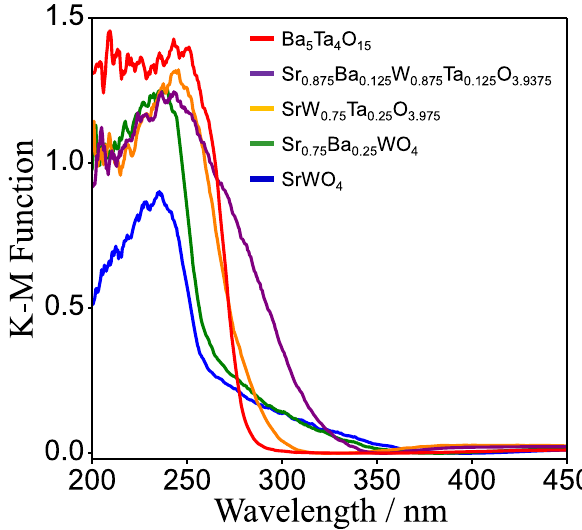
Fig. 2 UV–Vis diffuse reflectance spectra of Sr 1 - x Ba x W 1 - y Ta y - O 4 - (1/2) y : blue x , y = 0,0; green x , y = 0.25,0; orange x , y = 0,0.25; purple x , y = 0.125,0.125; and red Ba 5 Ta 4 O 15 crystals grown by a